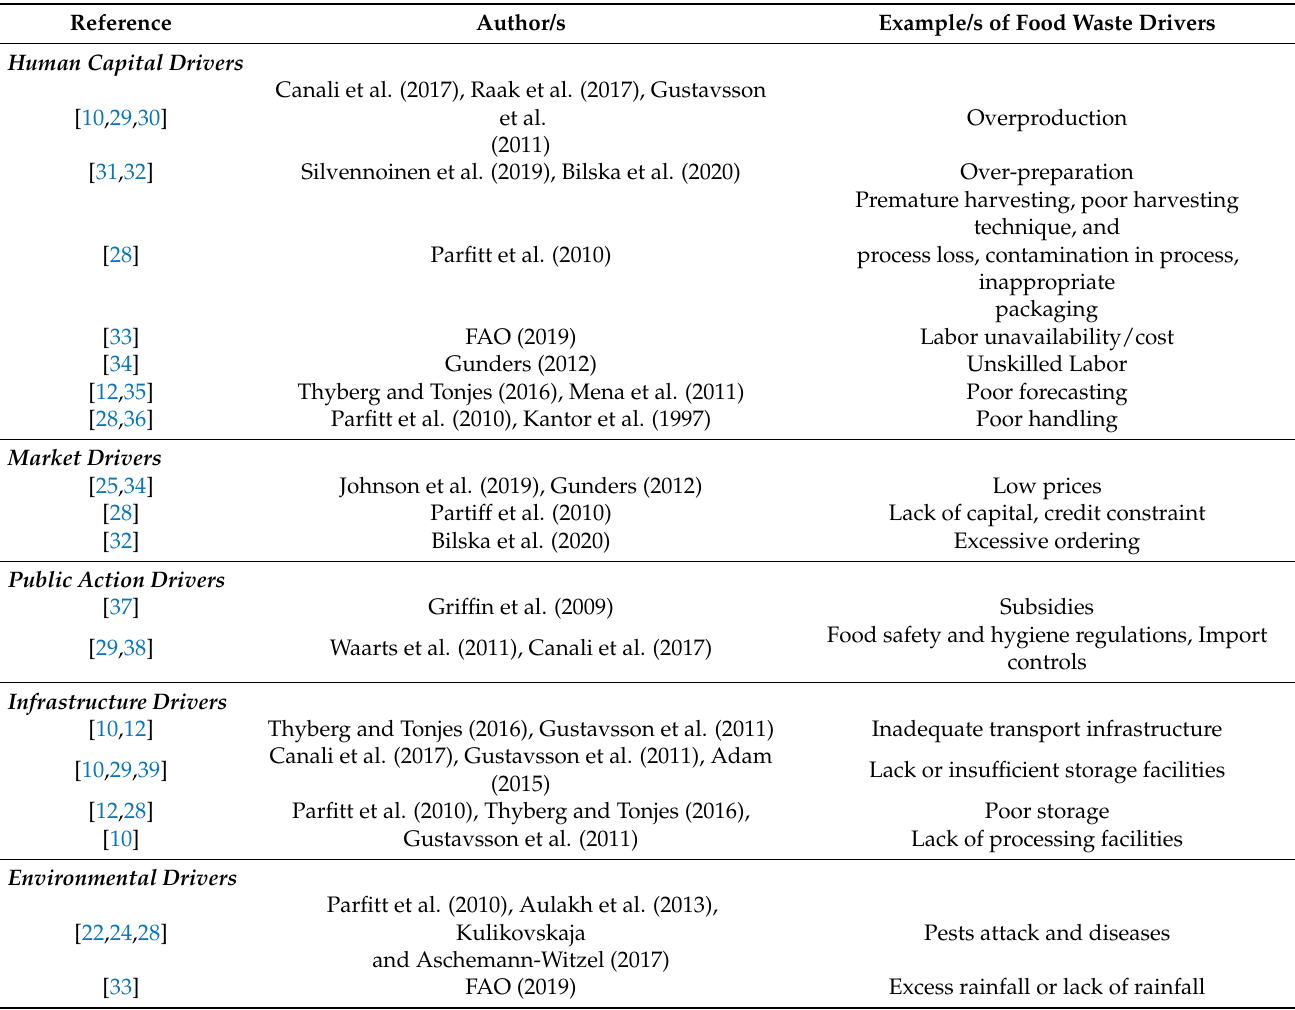
Table 1. Food waste drivers in agrifood supply